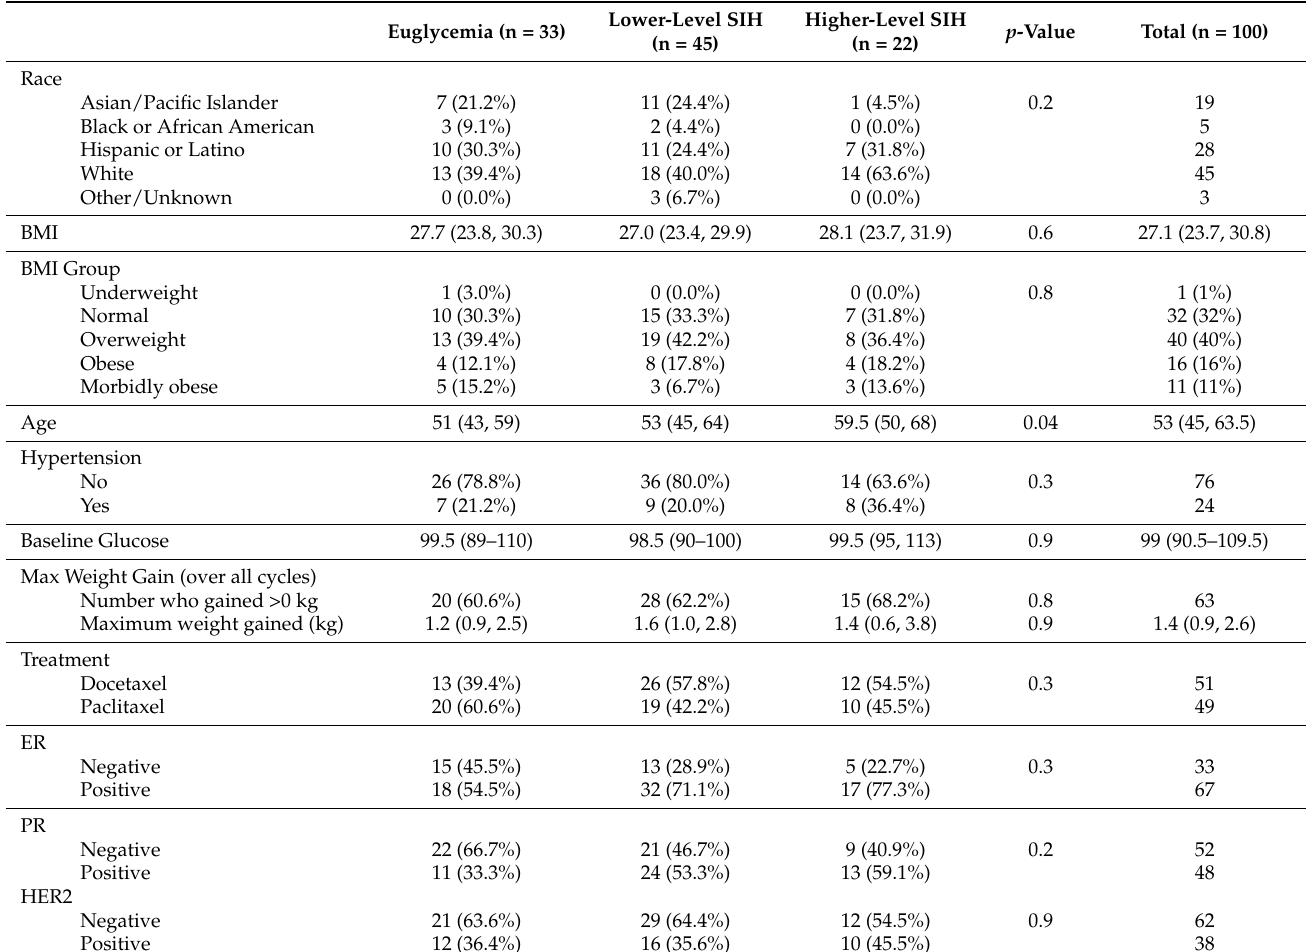
Table 1. Characteristics of patients (n = 100) classified as higher-level SIH (glucose > 200 mg/dL), lower-level SIH (glucose 140–199 mg/dL), and euglycemia (<140 mg/dL) 1 .